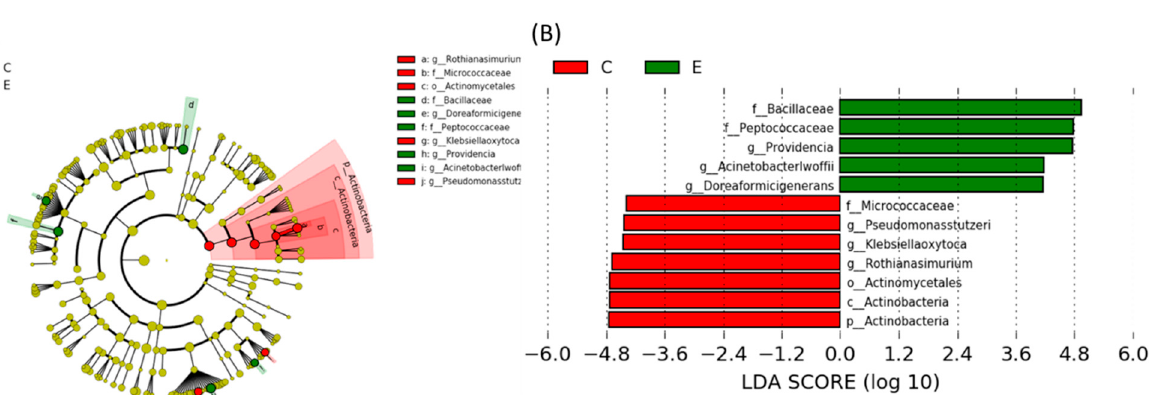
Figure 6. Effects of synbiotics on taxonomies of the fecal microbiotic compositions in rats with chronic ethanol feeding. ( A ) A linear discriminant analysis of the effect size (LEfSe) of the most significant abundance differences in the fecal microbiota between the C and E groups ( n = 6). ( B ) Bacteria meeting the linear discriminant analysis (LDA) threshold ( ≥ 2.5) ( n = 6).